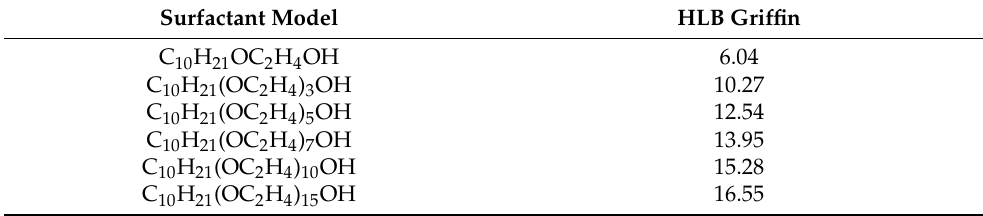
Table 4. Structure of tested surfactant models. Calculated HLB